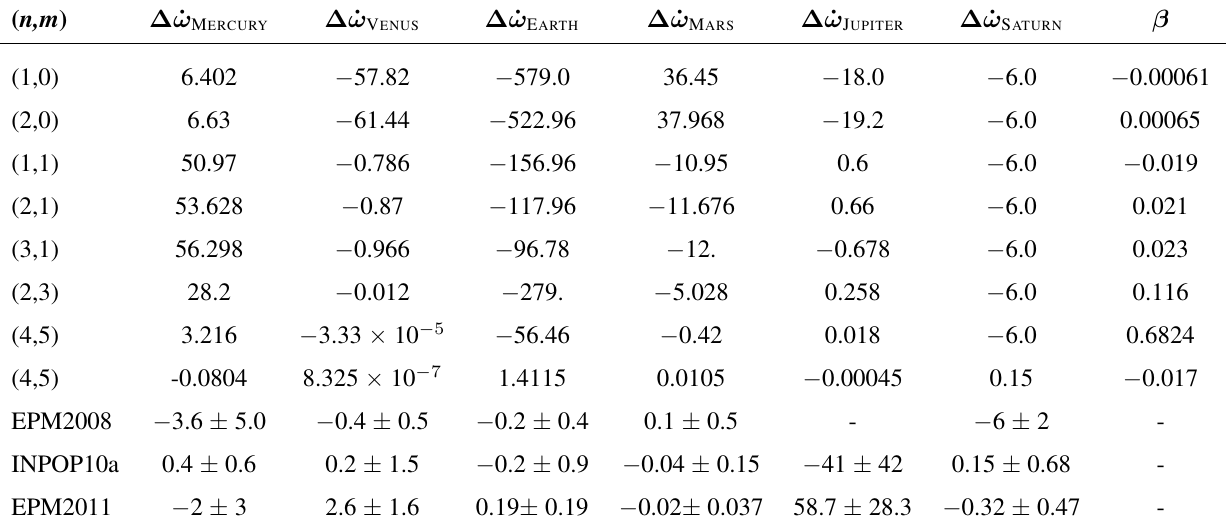
Table 2. Anomalous perihelion advance of the planets for the perturbation in Equation (3) and several pairs of the exponents n and m . The result is expressed in milliarcseconds per century.